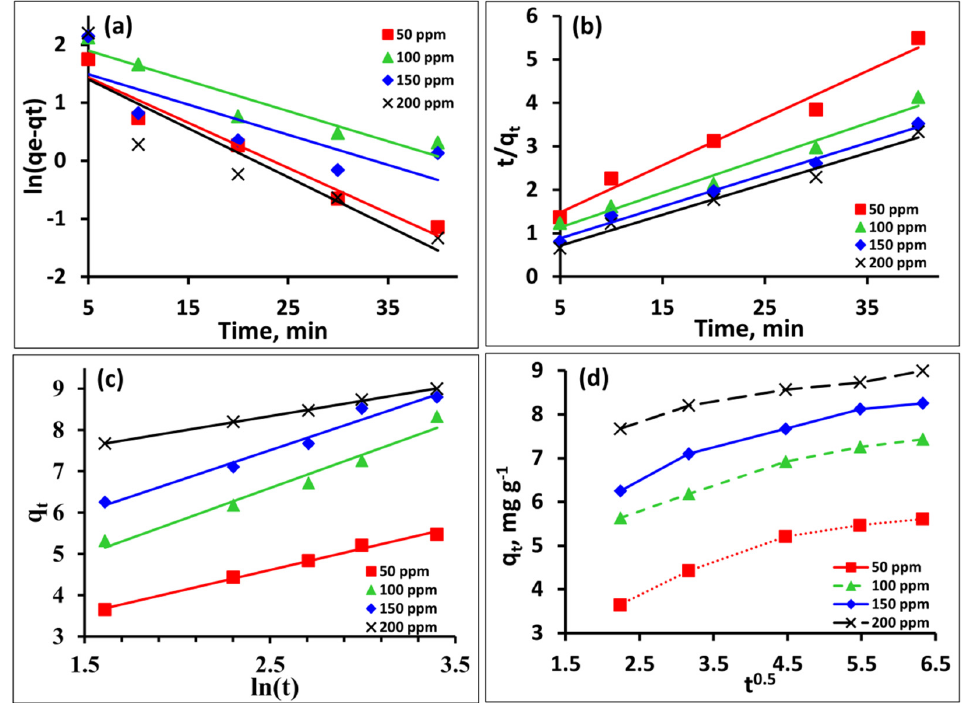
Figure 9. ( a ) Pseudo 1st order, ( b ) Pseudo 2nd order, ( c ) Elovich, and ( d ) Intraparticle diffusion models (50 mL, 50 ppm Co 2+ , 0.3 g ZrO 2 , time 30 min, temp 25 °C).